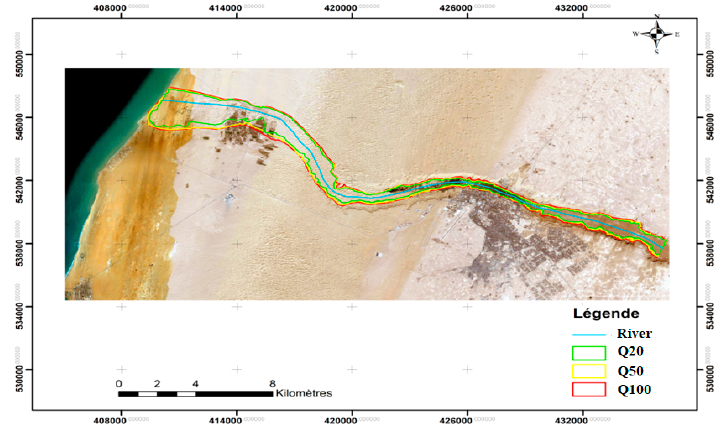
Figure 12. Mapping of the extent of the floodplain for the 2016 flash flood.